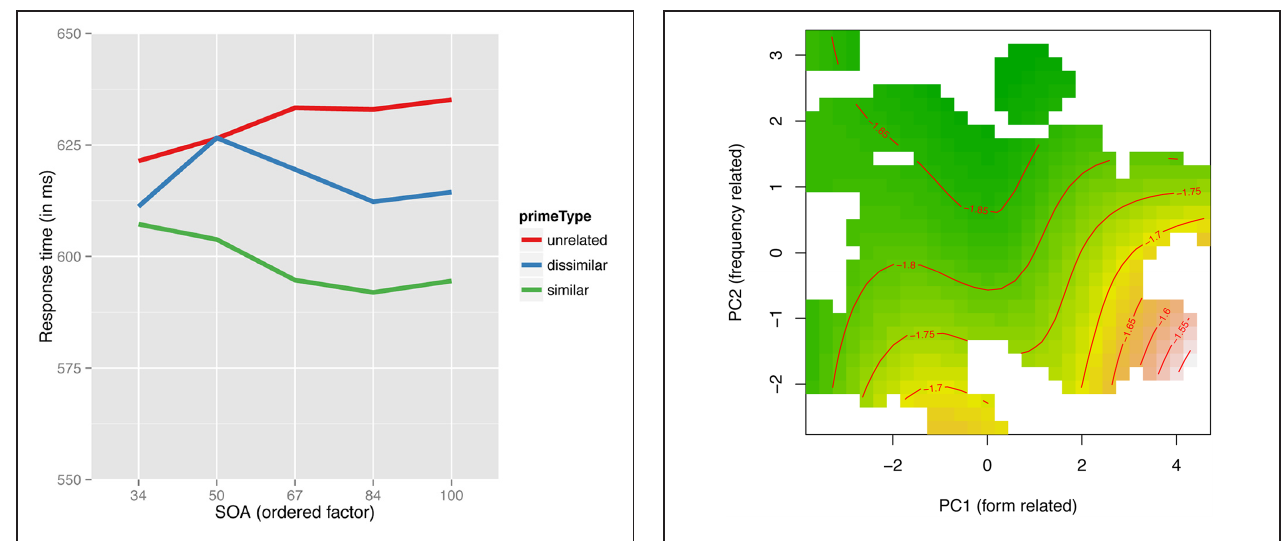
FIGURE 3 | Predicted values for the partial effect of prime type by SOA (linear term) interaction for response times over a range of SOAs.